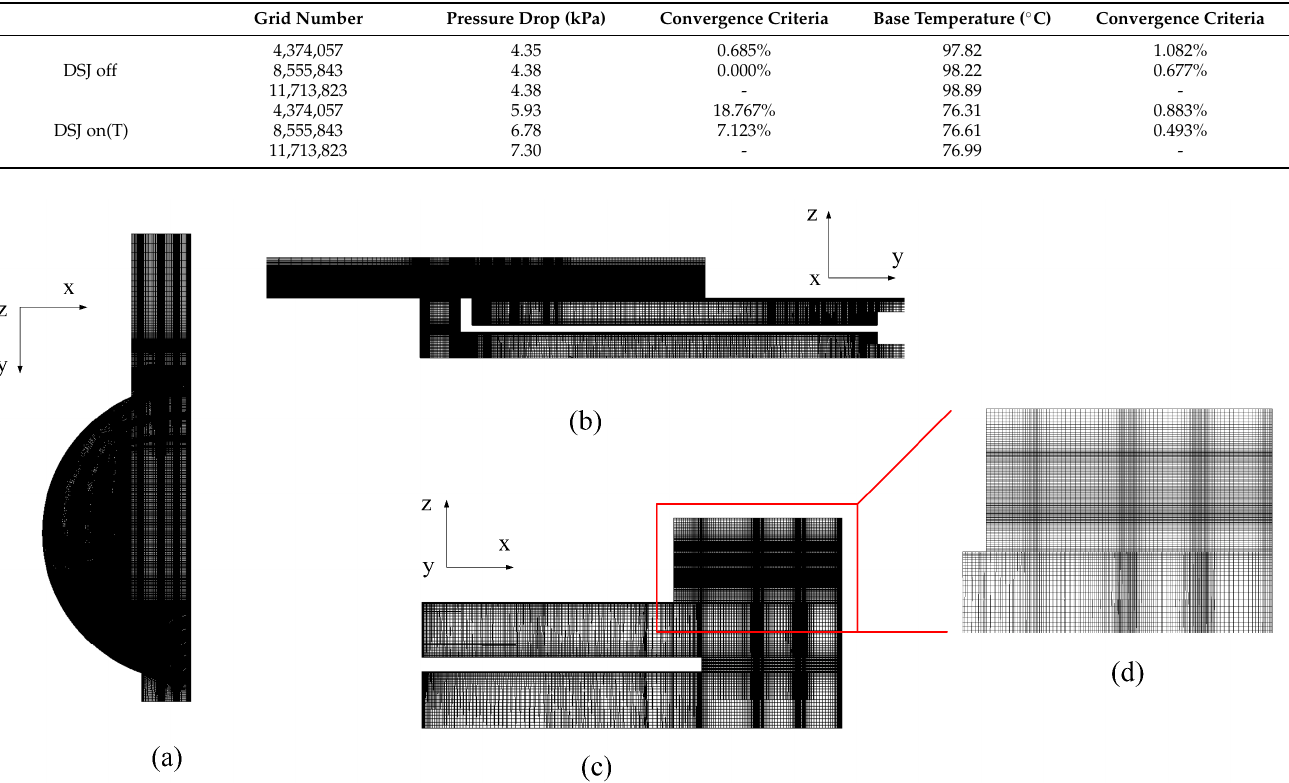
Table 1. Grid independence verification.